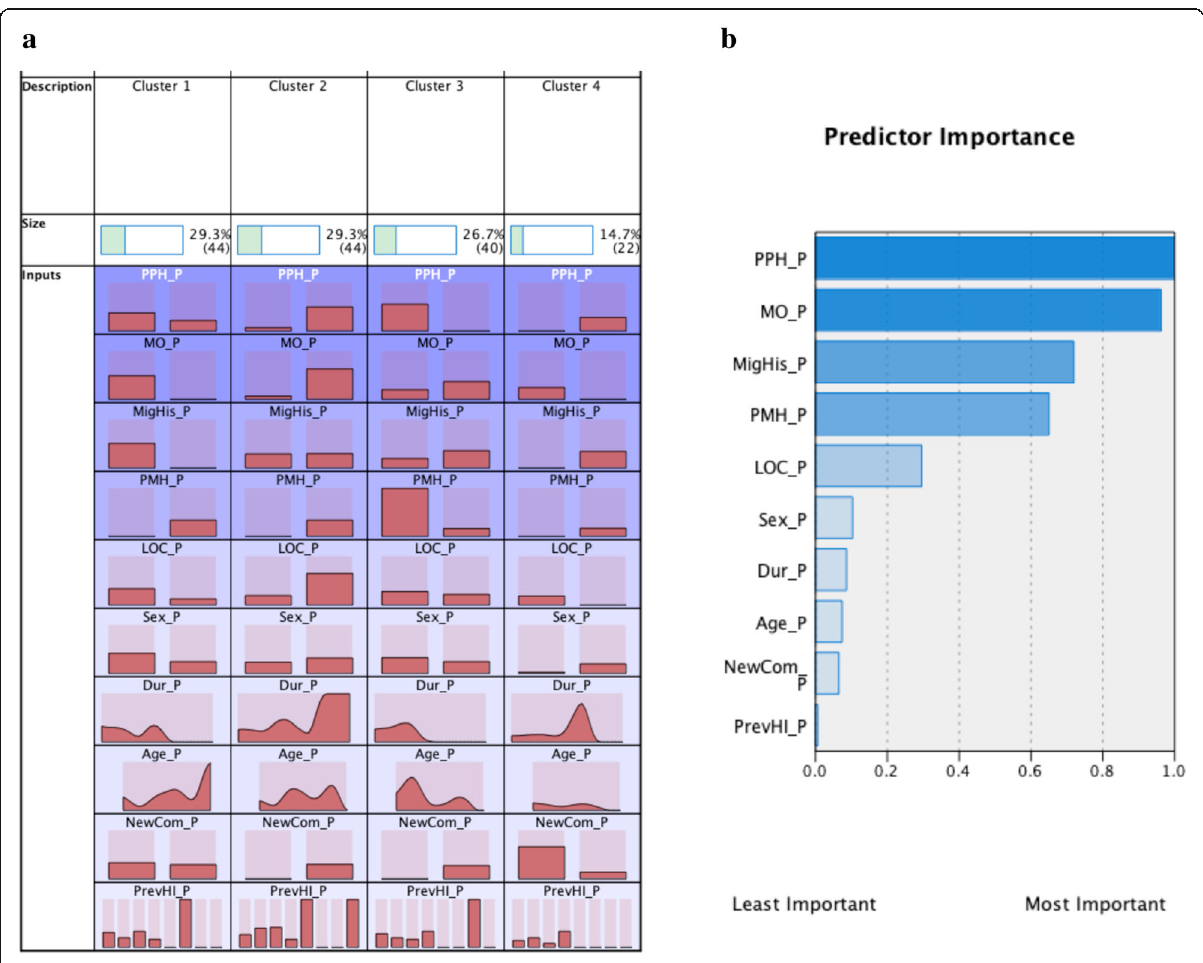
Fig. 2 Clusters within persistent PTH patients. Four clusters of persistent PTH patients were identified (a) . Under each cluster column, the following clinical variables were coded as “ present ” and “ absent ” : PPH_P (previous psychological history in persistent PTH), MO (medication overuse), MigHis (migraine history), PMH (previous medical history), LOC (loss of consciousness), NewCom (new comorbidities). “ Present ” is depicted by the left bars under each cluster column, while “ absent ” is represented by the right bars. For sex, left bars represent males while right bars represent females. The seven bars in previous head injury (PrevHI) represent frequency of head injuries found ranging from 0 (left) to 7 (right). Age distribution is shown ranging from 18 (left) to 90 (right) years. Cluster 1 had the lowest prevalence of a history of migraine (i.e. highest bar for “ absent ” MigHis). Cluster 2 featured the highest level of pre-existing psychological history, medication overuse, history of migraine, loss of consciousness, and the longest PTH duration (median 30 months). Cluster 3 had the shortest PTH duration (median 24 months) and the lowest prevalence of loss of consciousness. Cluster 4 exhibited the lowest prevalence of new PTH-associated comorbidities and head injuries (a) . The top 3 important predictors in descending order were pre-existing psychological history, medication overuse, and history of migraine